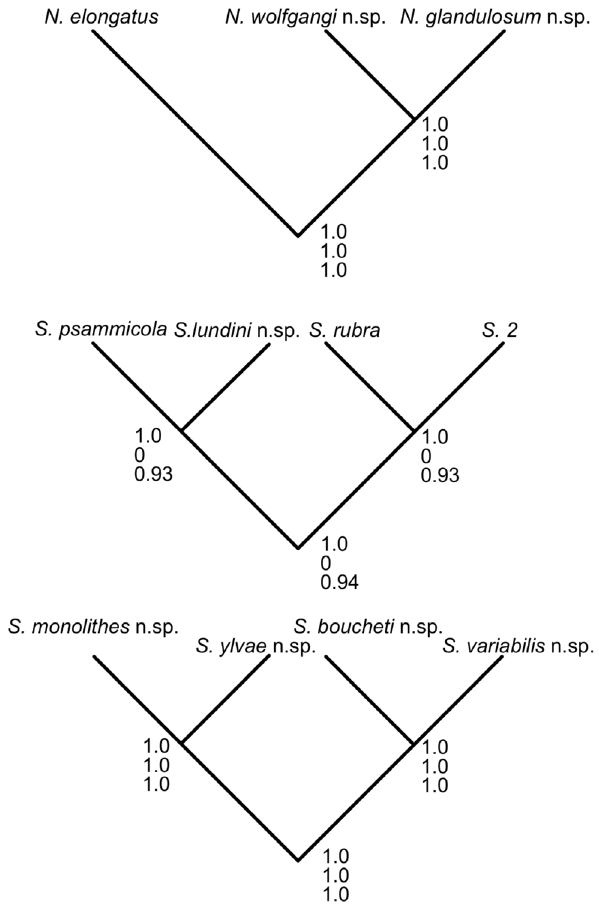
Figure 4. Results of the BP&P analyses for the tested species. Results given as nodal support for all Nemertinoides species (green in Fig. 2), mainly European Sterreria species (red in Fig. 2) and the extra- European Sterreria species (blue in Fig 2). Support values are Bayesian posterior probabilities for the different analyses in the order G(1/100), G(1/1000) and old root age (G(1/100) and G(1/10000)). The dataset was split in order to avoid artefacts due to unresolved topologies in the gene trees and increase confidence in the input topologies. Only clades represented by more than two specimens were tested in order to increase